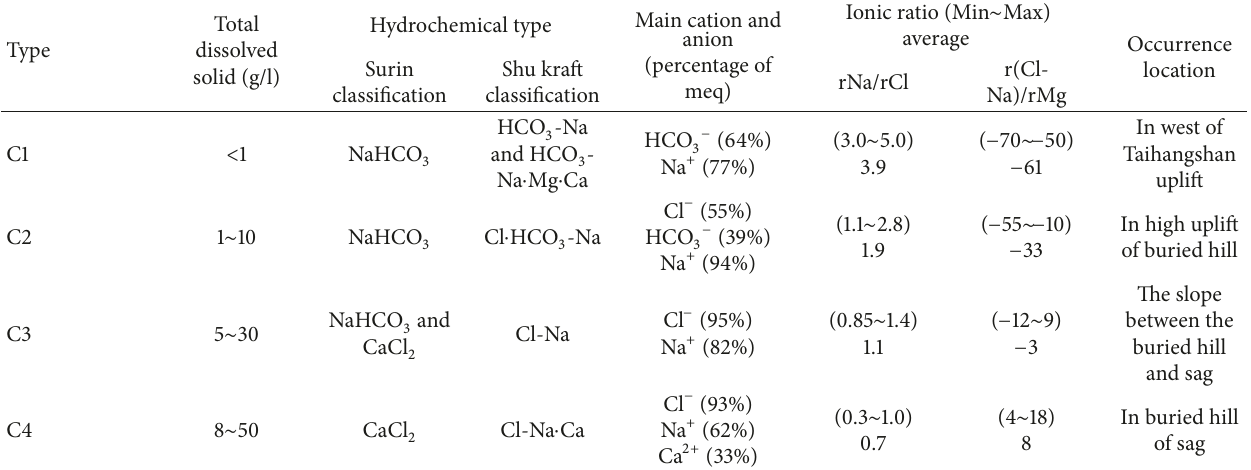
Table 1: The geochemical characteristics of different types of formation water in buried hill, Jizhong